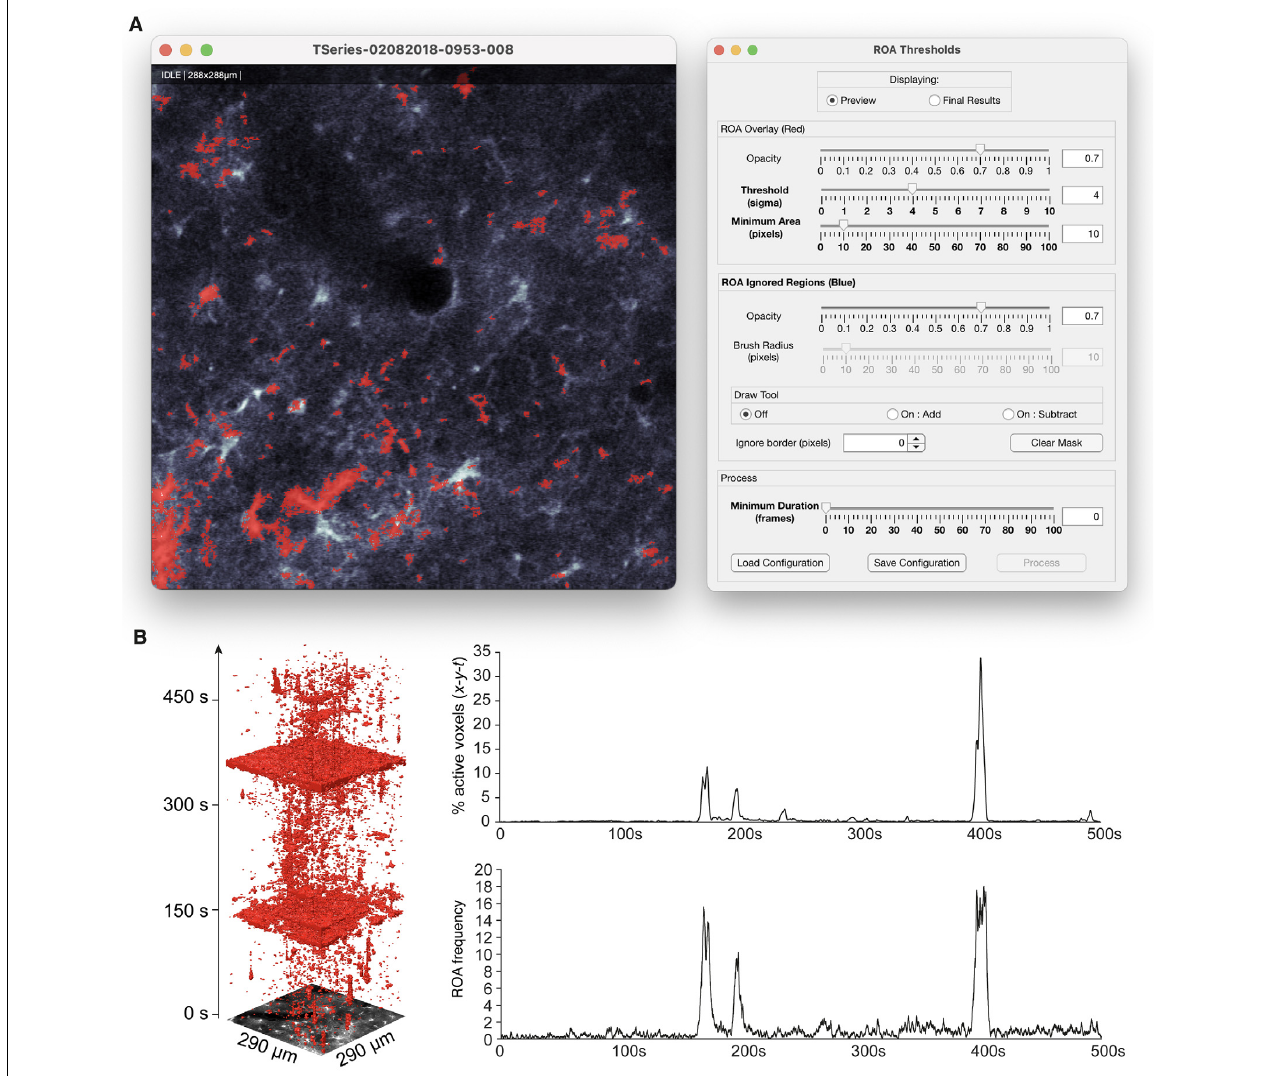
FIGURE 5 | ROA thresholding and output. (A) The thresholding step of the ROA algorithm is supported by a GUI that displays an overlay of the ROAs on top of the imaging data, and allows for interactive adjustment of the Ca 2+ event detection threshold, adjusting the minimum size and duration of events, and defining regions that should be ignored. (B) An x-y-t volume rendering of a time series of astrocytic Ca 2+ signals and corresponding traces of ROA density (% active voxels) and ROA frequency events per minute per µ m 2